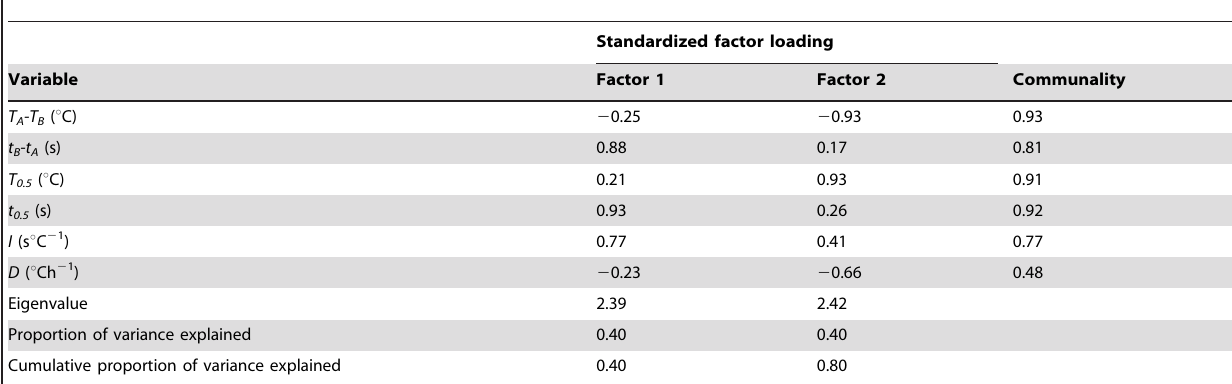
Standardized factor loading